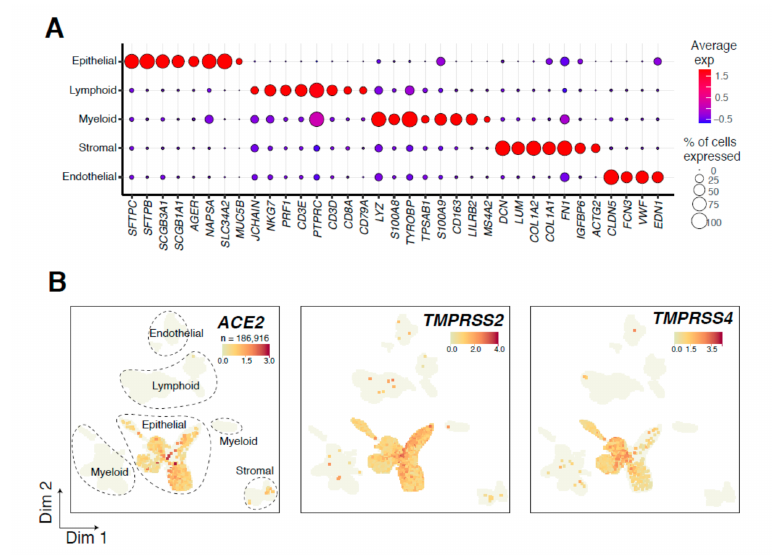
Figure 1. Overview of 186,916 tumor- and normal-derived lung cells analyzed by scRNA-seq. ( A ) Bubble plot show-ing the expression of markers indicative of major lineages in the lung ecosystem. Both the fraction of cells expressing (indicated by the size of the circle) as well as their scaled expression levels (indicated by the color of the circle) are shown. ( B ) Uniform manifold approximation and projection (UMAP) embedding of cells from tumor and multiple nor-mal samples per patient (19 samples from 5 LUAD patients). Cells are colored by expression level of ACE2 , TMPRSS2 , or TMPRSS4